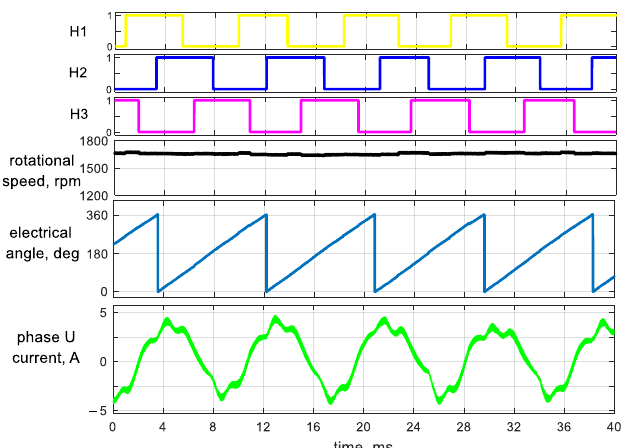
Figure 8. Waveforms recorded using the sinusoidal control technique of the BLDC motor with the proposed method of rotor position estimation.